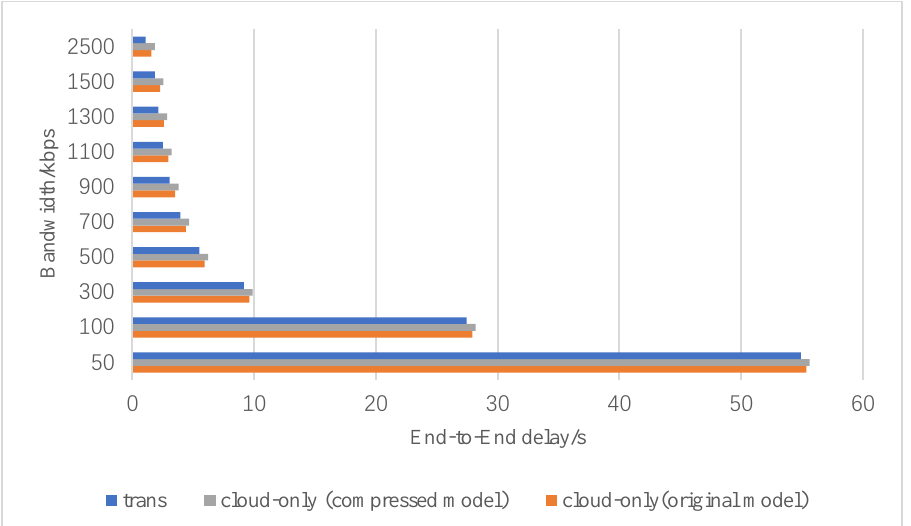
Figure 6. Inference latency under